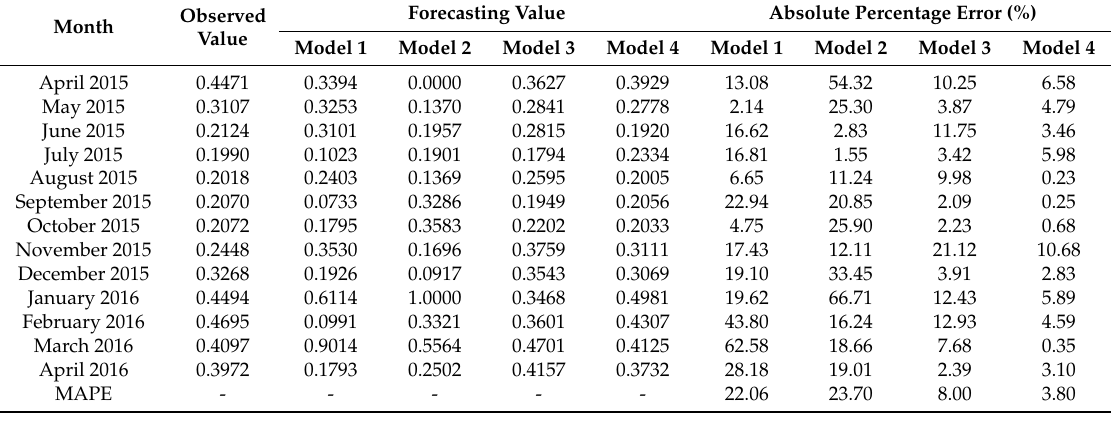
Table 7. Forecasting results of the proposed model compared with the other three models. Month